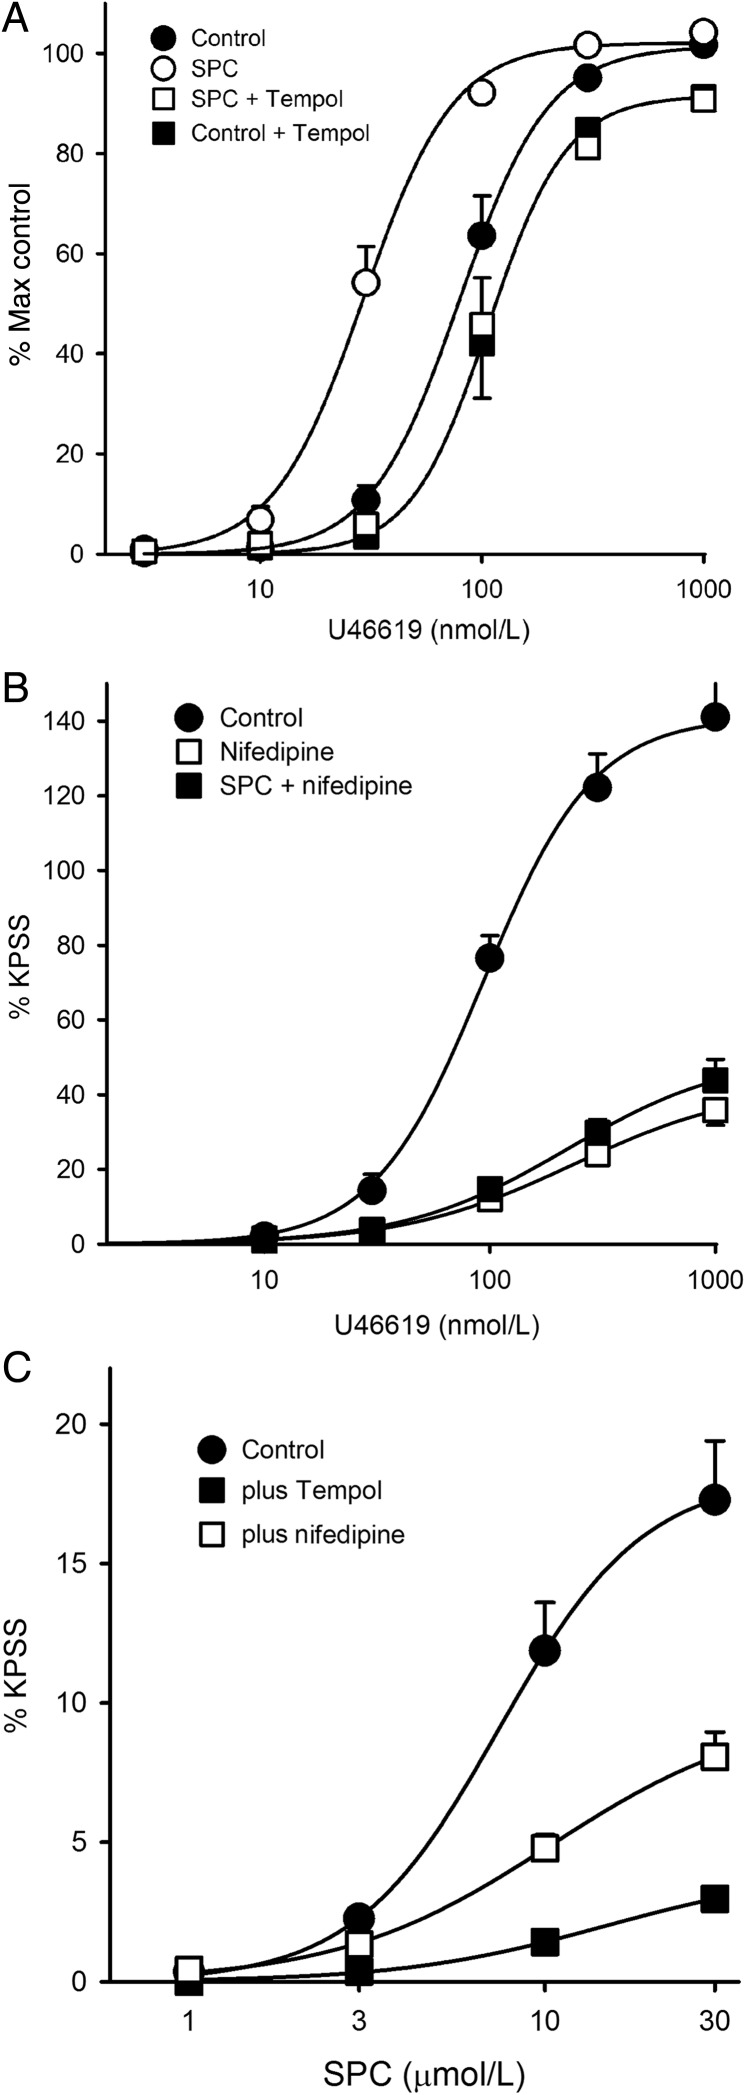
U46619 and SPC-induced contraction, and effects of Tempol and nifedipine. (A) Cumulative concentration–response curves for U46619: control (filled circle), SPC (1 µmol/L; open circle), SPC + Tempol (open square); 12 MA (6 rats). Tempol alone (filled square); n = 8 MA (4 rats). Mean pD2: control: 7.11 ± 0.02; SPC: 7.53 ± 0.03, P < 0.001 vs. control; SPC + Tempol: 6.99 ± 0.02, P < 0.001 vs. SPC, P < 0.02 vs. control; RM ANOVA, Holm-Sidak post hoc. pD2 for Tempol alone: 6.90 ± 0.08, NS vs. Tempol + SPC; P < 0.05 vs. Control; one-way ANOVA, Holm-Sidak post hoc. Bars = SEM. (B) Similar to A, but in the presence of nifedipine (3 µmol/L; open square), and SPC + nifedipine (filled square); 15 MA (9 rats). Control: pD2: 7.04 ± 0.06, Vmax: 144 ± 13% KPSS; nifedipine: pD2: 6.64 ± 0.05, P < 0.001 vs. control, Vmax: 43 ± 5% KPSS, P < 0.001 vs. control; SPC + nifedipine: pD2: 6.67 ± 0.03, NS vs. nifedipine alone, Vmax: 53 ± 6% KPSS, NS vs. nifedipine alone; RM ANOVA, Holm-Sidak post hoc. (C) Cumulative concentration–response curves for SPC in MA (filled circles); 16 MA (10 rats), with Tempol (filled squares); 8 MA (5 rats), or nifedipine (open squares); 10 MA (6 rats). SPC: pD2: 5.08 ± 0.04, Vmax: 16.8 ± 1.3% KPSS; SPC + Tempol: pD2: 4.84 ± 0.06, P < 0.02 vs. control, Vmax: 4.24 ± 1.2% KPSS, P < 0.001 vs. control; SPC + nifedipine: pD2: 5.10 ± 0.06, NS vs. control, Vmax: 8.25 ± 1.1% KPSS, P < 0.002 vs. control, P < 0.05 vs. Tempol; one-way ANOVA, Holm-Sidak post hoc. Bars = SEM (not shown if smaller than symbol).